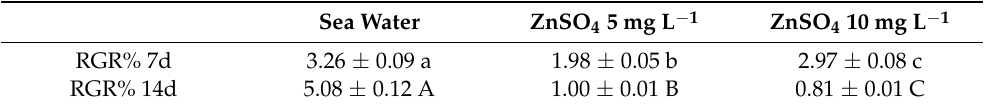
Figure 1. Fresh weight of Caulerpa grown in seawater (Sw — black bars), seawater + ZnSO 4 5 mg L −1 (ZnL — dark grey bars) and seawater + ZnSO 4 10 mg L −1 (ZnH — light grey bars) for 14 days. Letters indicate significant differences between treatments and days ( p ≤ 0.05). Letters indicate ANOVA significance between treatments. Table 1. Relative growth rate (RGR%) of Caulerpa grown in seawater and in presence of ZnSO 4 at different concentrations. Uppercase (7d) and lowercase (14d) letters indicate significant differences between treatments at corresponding days ( p ≤ 0.05).